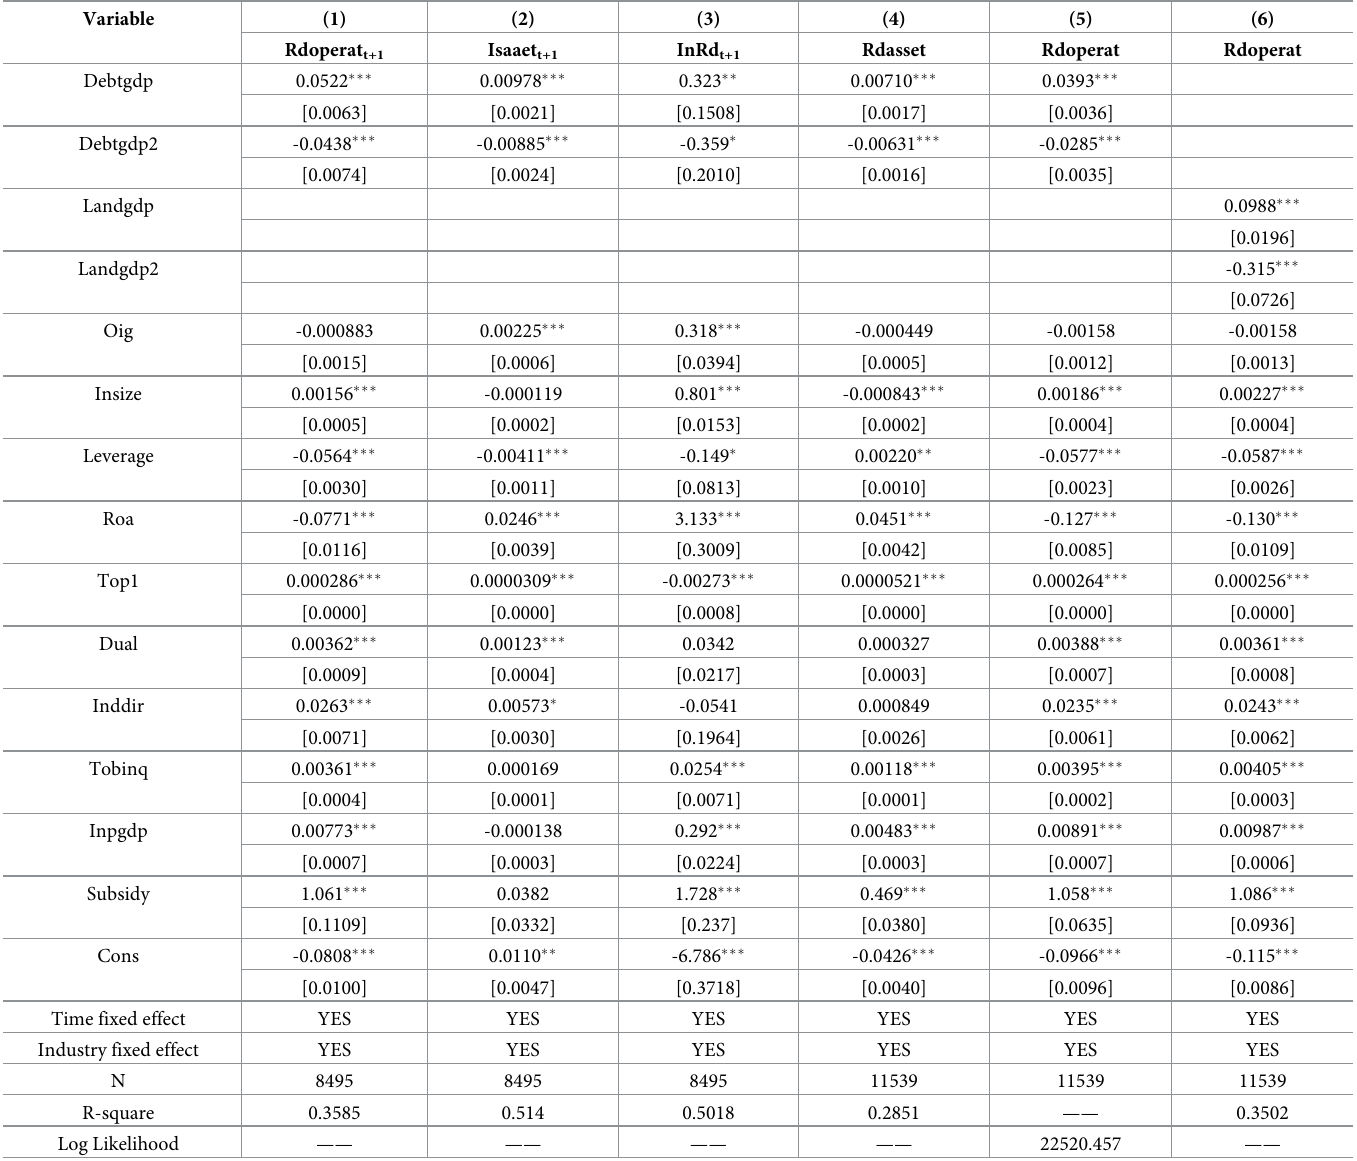
Table 4. Regression results of robustness